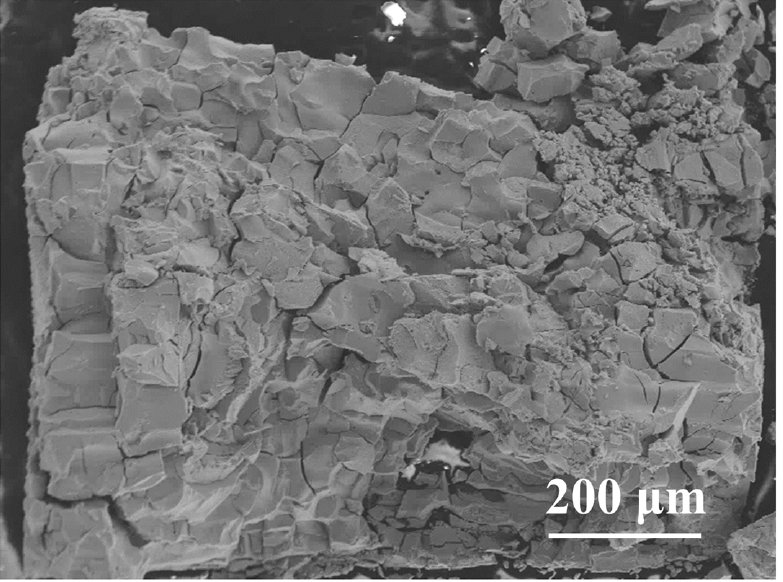
Figure 7. The cross-sectional SEM image of the bulk np-Pd fabricated by the two-step potentiostatic dealloying of Ni 80 Pd 20 .